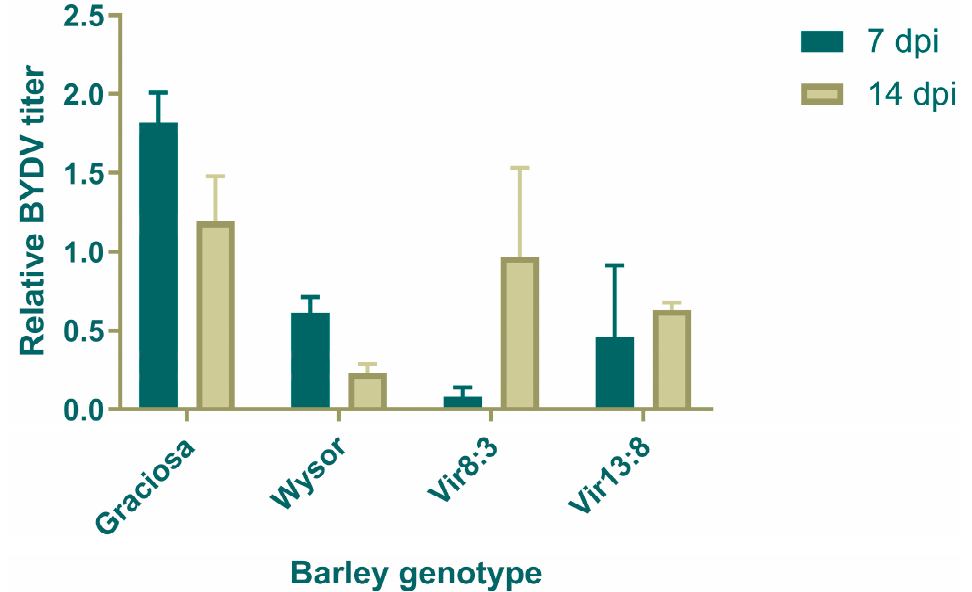
Figure 2. Relative Barley yellow dwarf virus (BYDV) titer in infected barley ( Hordeum vulgare L.) genotypes 7 and 14 days post inoculation (dpi). The standard deviation is expressed as error bars. The whole plants (above-ground biomass) was collected and assayed. Relative titer values were calculated using the 2 − ∆∆ Ct method.